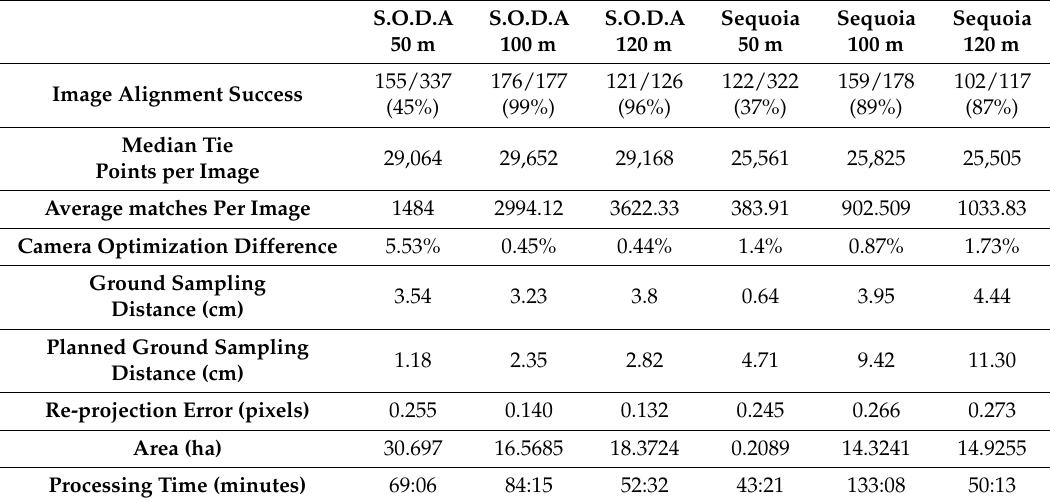
Table 1. Flying height and sensor combination influence on SfM processing success results.